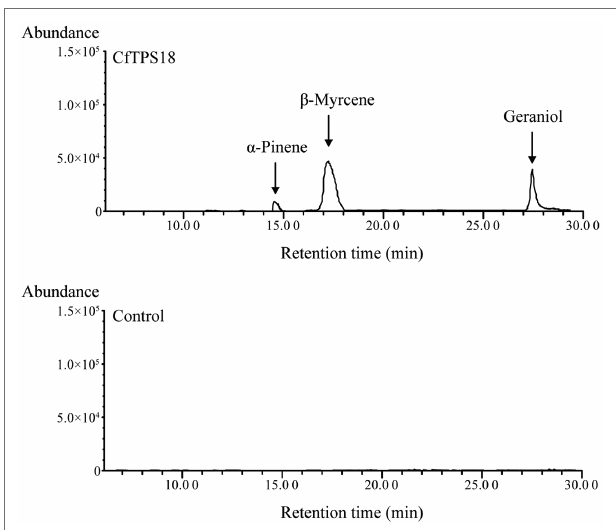
FIGURE 9 | Enzymatic assays after incubating recombinant CfTPS18 . Reactions only performed with GPP were used as the blank control. The retention time was compared with the NIST Mass Spectral Library.